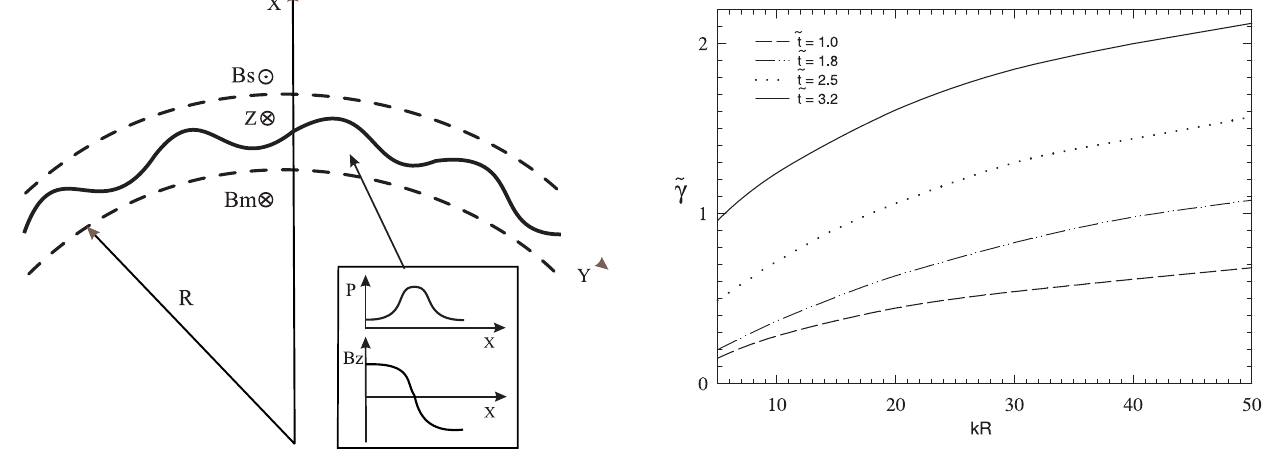
Fig. 5. Normalized instability growth rate as a function of kR for the nonsteady magnetosheath profiles corresponding to different times: t = 1.0; 1.8; 2.5; 3.2.